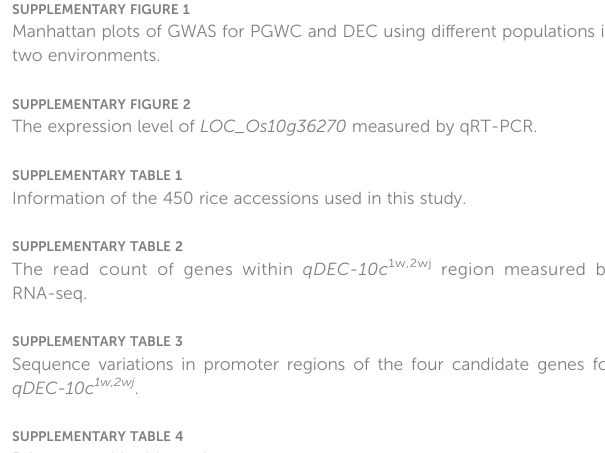
SUPPLEMENTARY TABLE 1 Information of the 450 rice accessions used in this study. SUPPLEMENTARY TABLE 2 The read count of genes within qDEC-10c 1w,2wj region measured by RNA-seq. SUPPLEMENTARY TABLE 3 Sequence variations in promoter regions of the four candidate genes for qDEC-10c 1w,2wj . SUPPLEMENTARY TABLE 4 Primers used in this